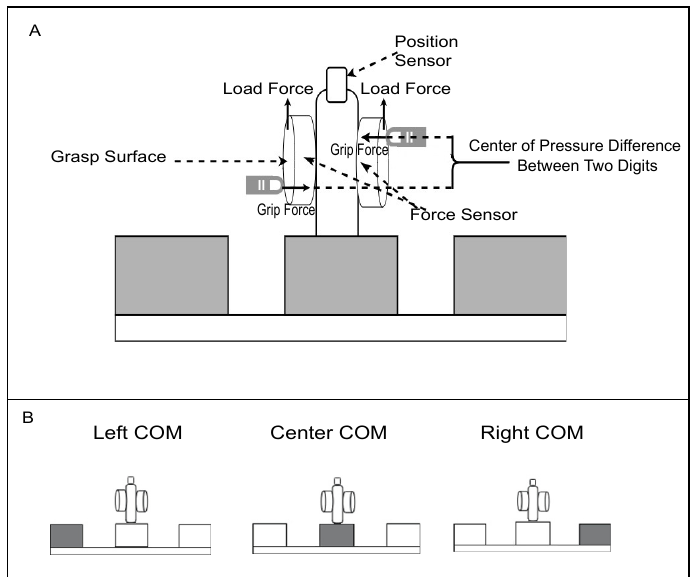
Figure 1. ( A ) custom-made device with force transducers and position sensor. ( B ) Shaded box represents where the heavy weight (180 g) is for each center of mass (COM)